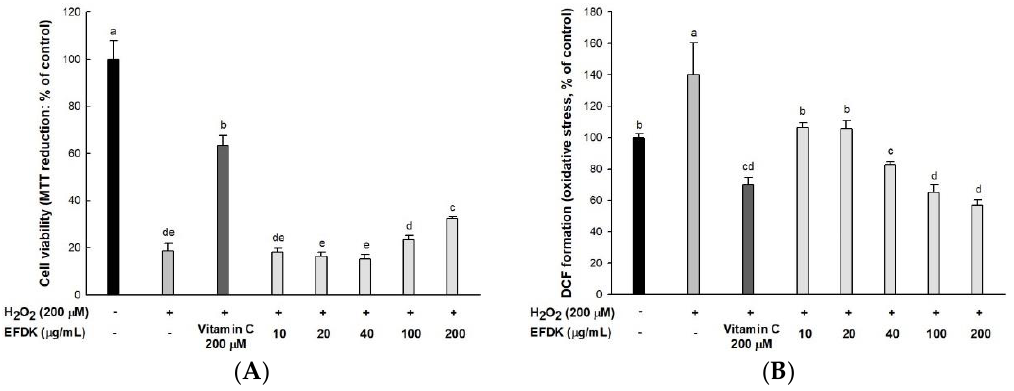
Figure 1. Neuroprotective effect of ethyl acetate fraction from persimmon (EFDK) in HT22 cells. ( A ) Cell viability; ( B ) cellular oxidative stress. Results shown are mean ± SD ( n = 3). Data were statistically represented at p < 0.05, and different small alphabets mean statistical significance.